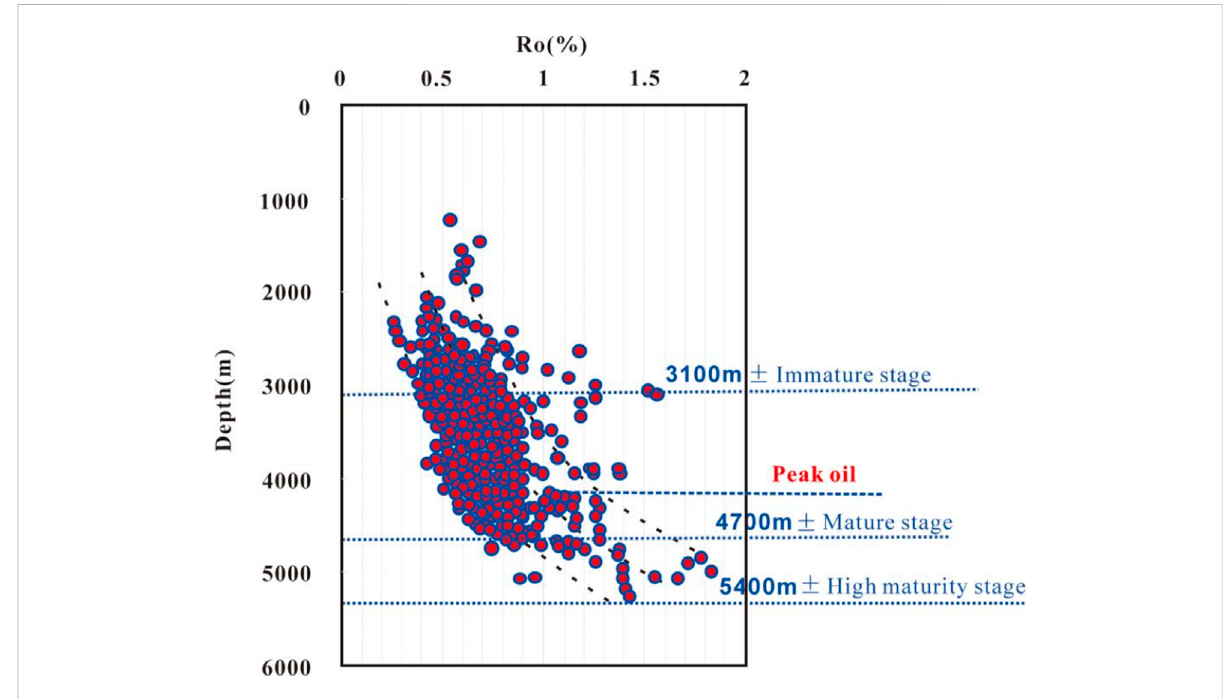
FIGURE 5 Relationship between R o and depth of source rocks in Nanpu Sag.